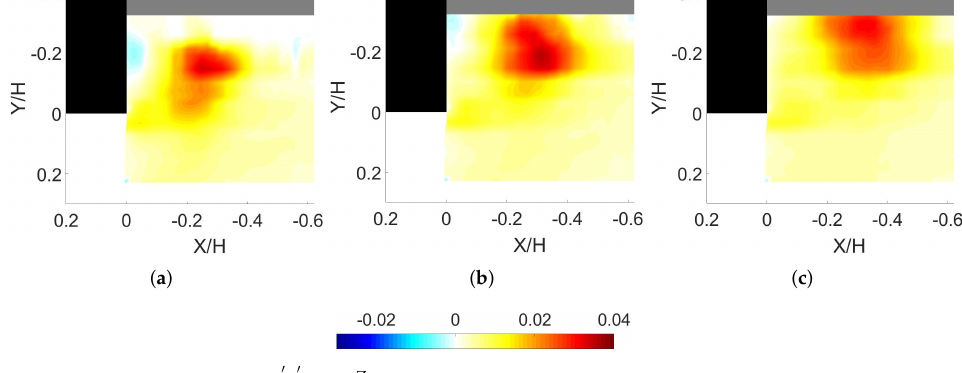
Figure 7. ( a – c ) show the < − u